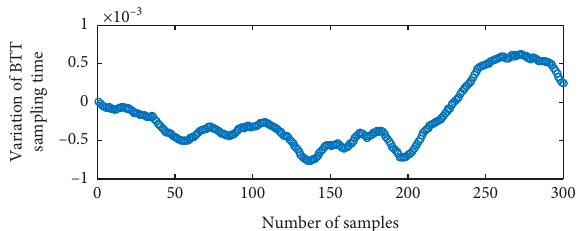
Figure 10: The variation of BTTsampling time using experimental rotating speed.